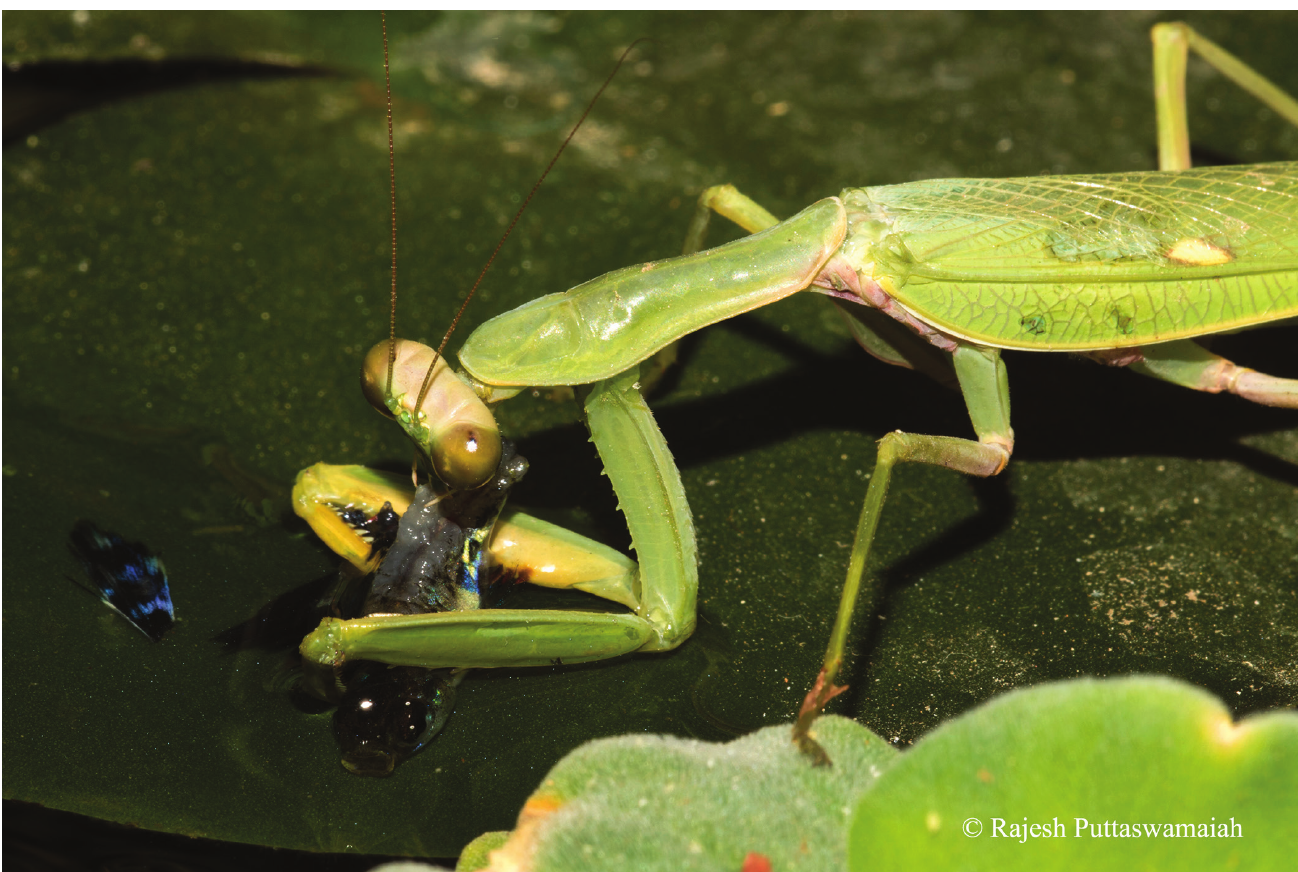
Fig. 2. Hierodula tenuidentata eating Poecilia reticulata from the tail while the fish is still alive and breathing in the water. Photo by R.